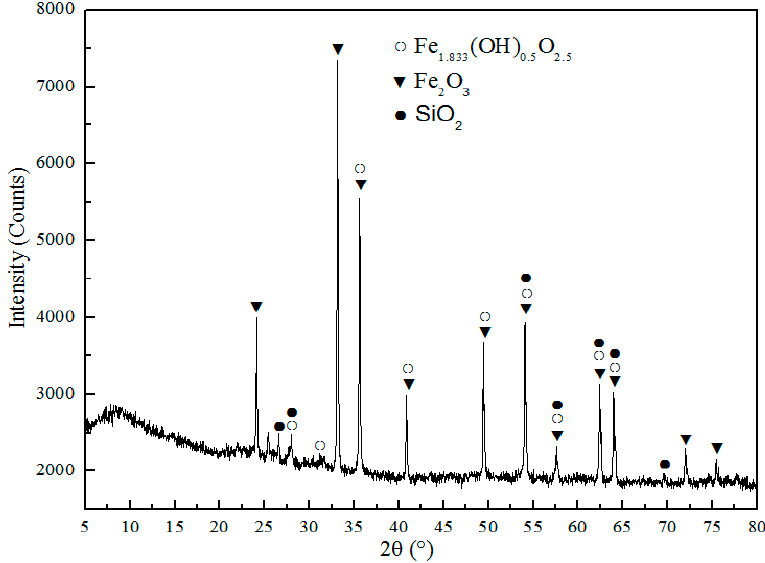
Figure 11. XRD pattern of CT after chlorination roasting in the microwave field.